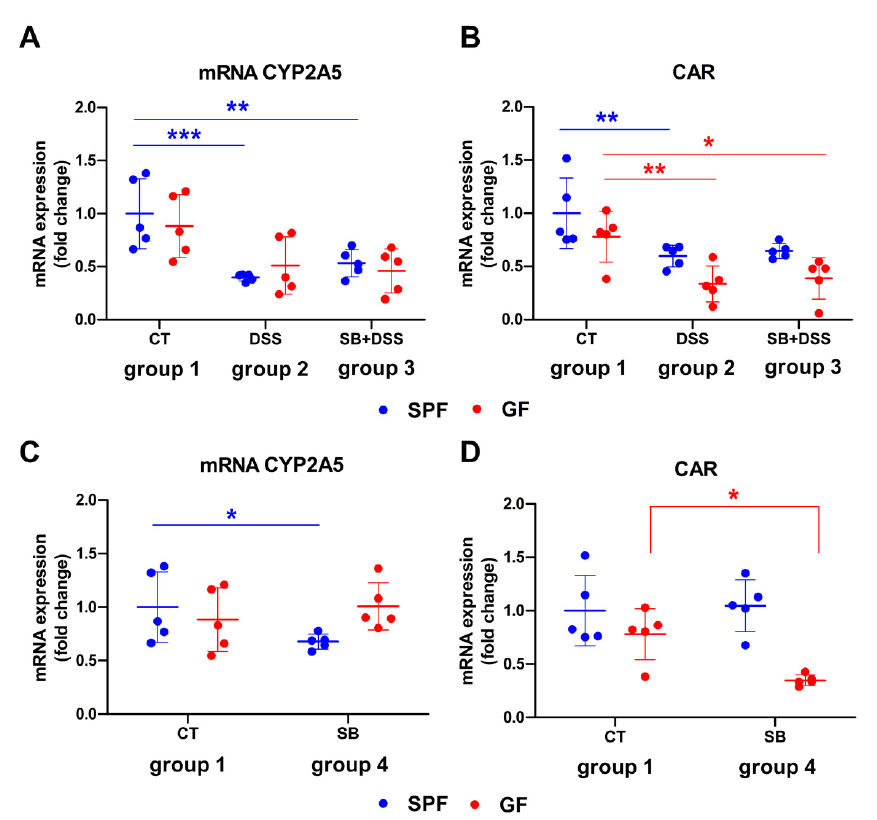
Figure 1. Comparison of mRNA expression of CYP2A5 and CAR in murine liver of GF and SPF mice. Gene expression of ( A , C ) CYP2A5 and ( B , D ) constitutive androstane receptor (CAR). Results are expressed relative to SPF healthy control group (CT) and represent means ± SD. Significance of differences from the control was determined using one-way analysis of variance (ANOVA) with the Tukey’s multiple post-hoc test being used for comparison of experimental groups to respective SPF and GF controls (*** p < 0.001, ** p < 0.01, * p < 0.05). CT (group 1): drinking water for 1 week; DSS (group 2): 1 week 2.5% DSS in drinking water; SB + DSS (group 3): 0.5% SB in drinking water for 2 weeks followed by a week of 2.5% DSS in drinking water; SB (group 4): 0.5% SB in drinking water for 2 weeks.